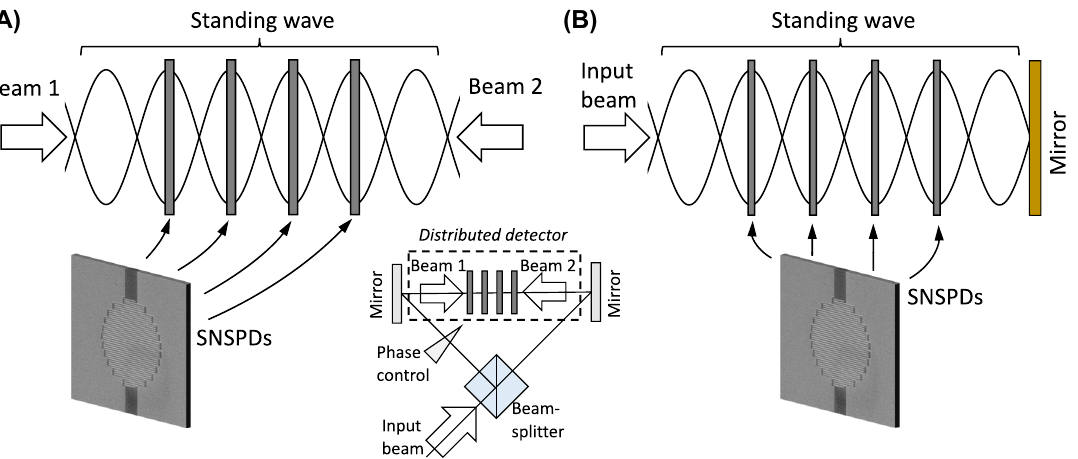
Figure 1: Coherent detection of light with a distributed detector. Multiple SNSPDs are placed at separate anti-nodes of the standing wave, guaranteeing total and uniform light absorption. A distributed detector can be fabricated in a phase-sensitive design (A), providing control over light absorption in a full range, or in a phase-insensitive design (B), always operating in the total absorption regime. The inset in (A) shows an interferometric setup for phase-sensitive detection. SEM images show NbTiN